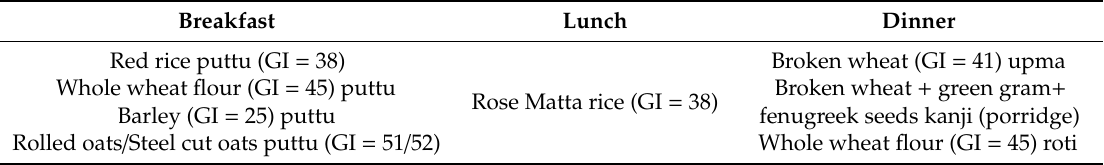
Table 1. The diet plan for the low glycemic index (GI) diet group. Breakfast Lunch